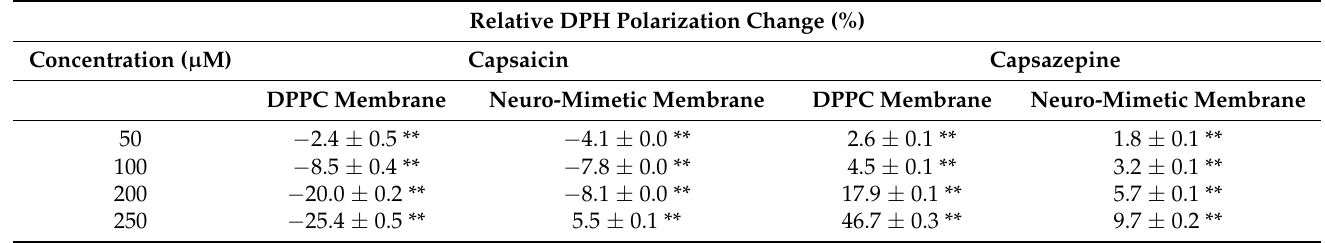
Table 1. Comparison of membrane interactivity between DPPC and neuro-mimetic membranes.